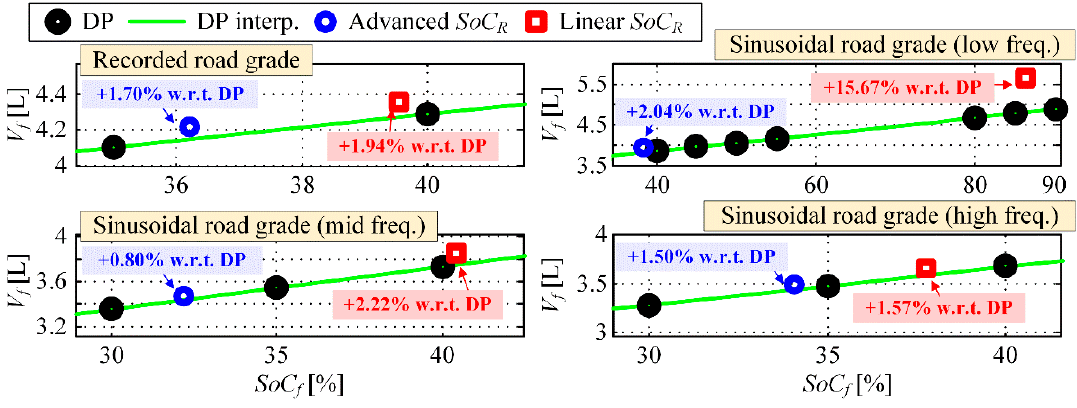
Figure 16 . DP optimal and simulated SoC trajectories (the latter obtained for linear and more advanced, nonlinear SoC reference trajectories) for ( a ) recorded, ( b ) sinusoidal low frequency, ( c ) sinusoidal mid frequency and ( d ) sinusoidal high frequency road grade profiles, no LEZ case, and 4xDUB driving cycle.